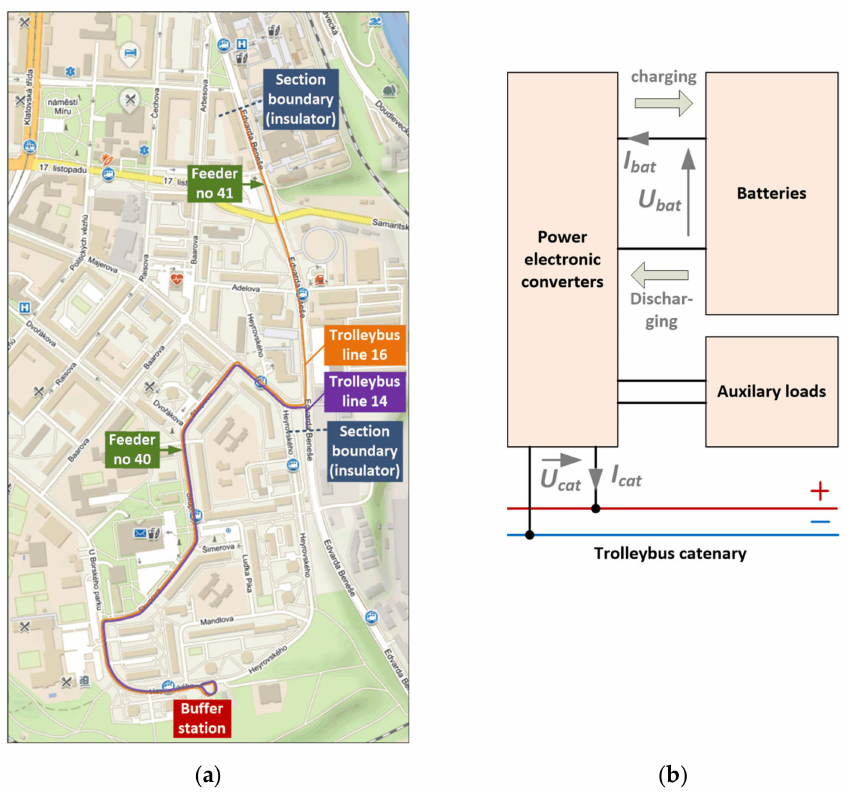
Figure 1. Buffer station in Pilsen: ( a ) topography of supply section (based on “mapy.cz”); ( b ) func- tional